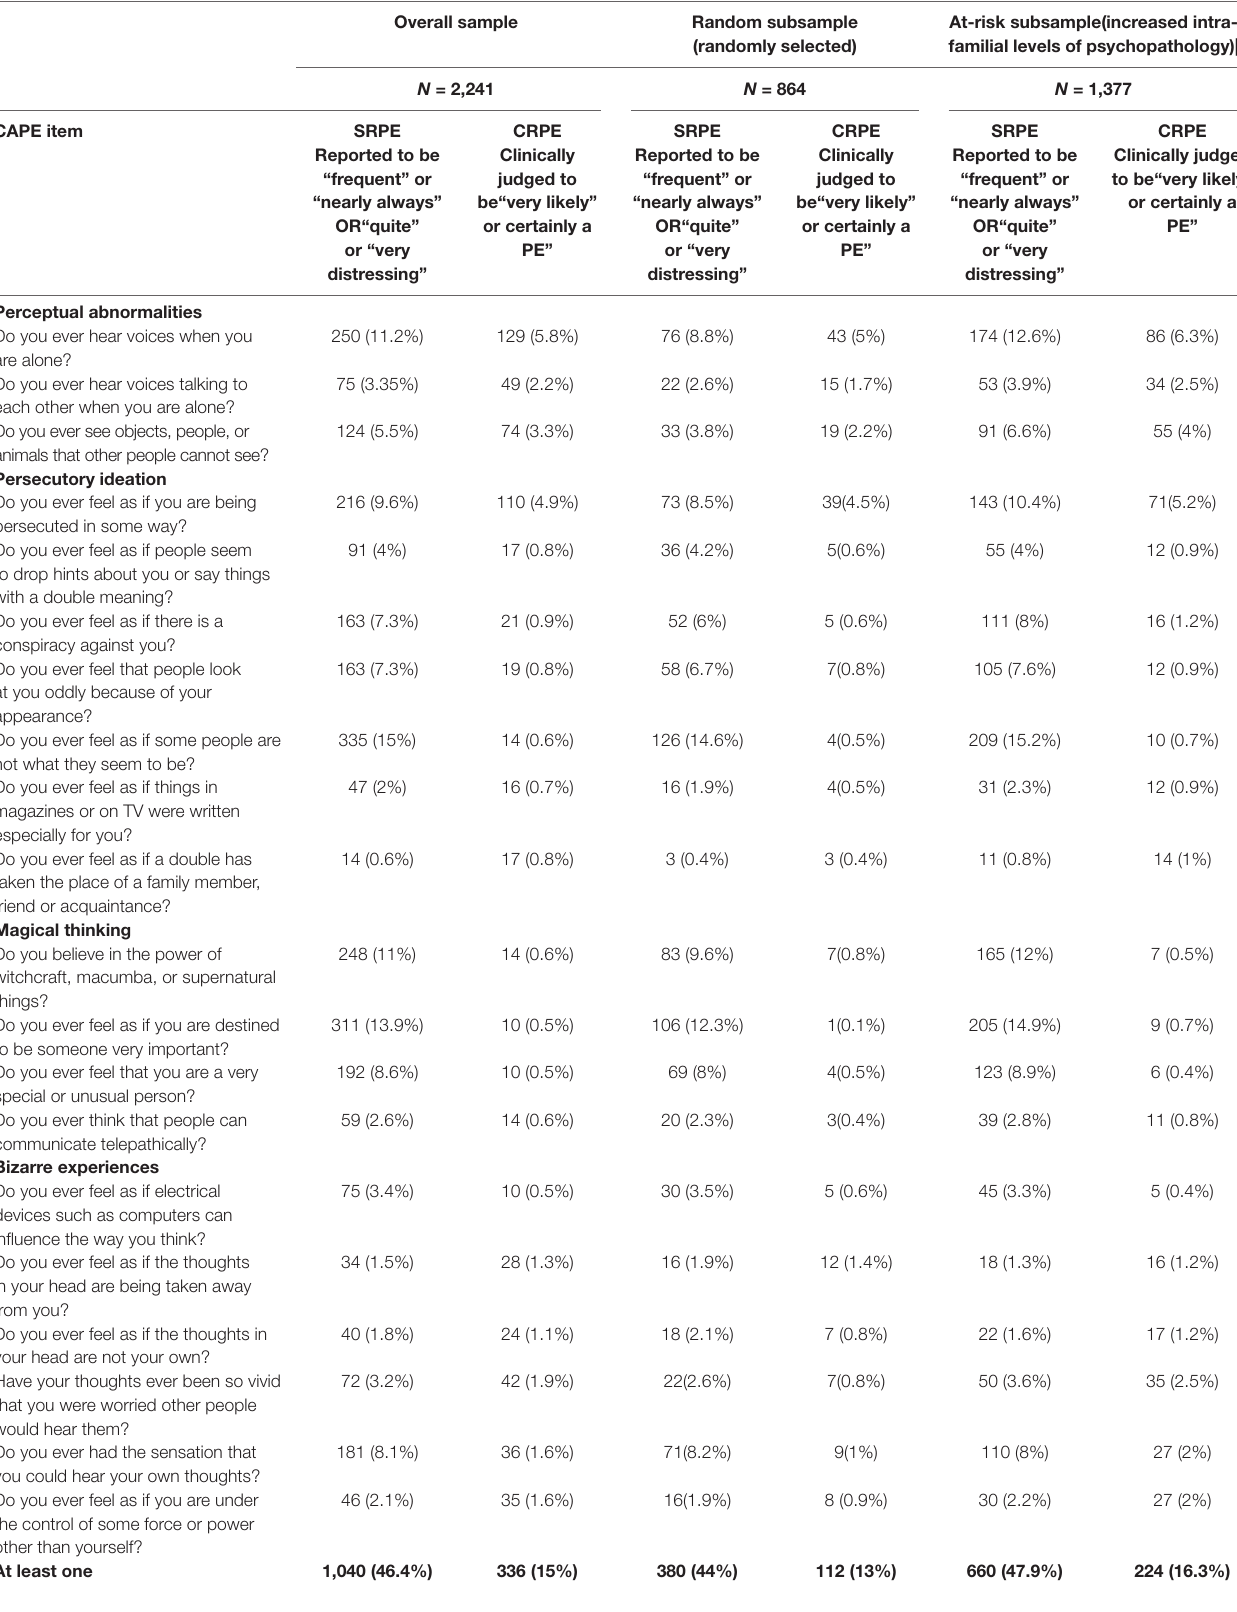
TABlE 2 | Frequency of self-reported (SRPE) and clinically relevant psychotic experiences (CRPE) per item for the overall sample and subsamples according to recruitment methodology (increased familial levels of psychopathology and randomly selected). Overall sample Random subsample (randomly